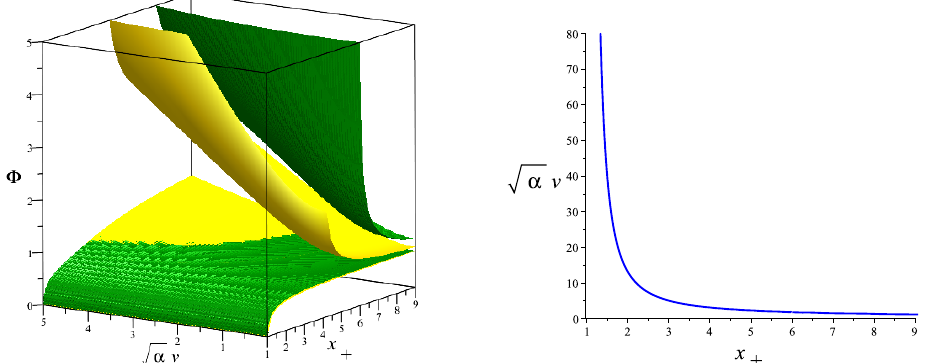
Figure 13 . At the left hand sid the surface where side we show the surface where